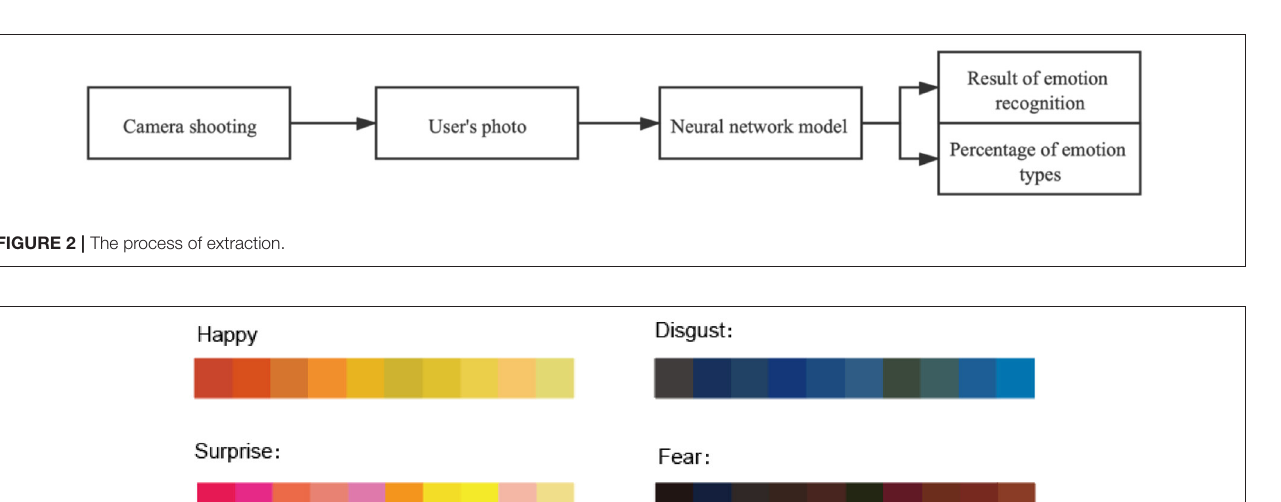
FIGURE 1 | The design process based on emotion analysis.